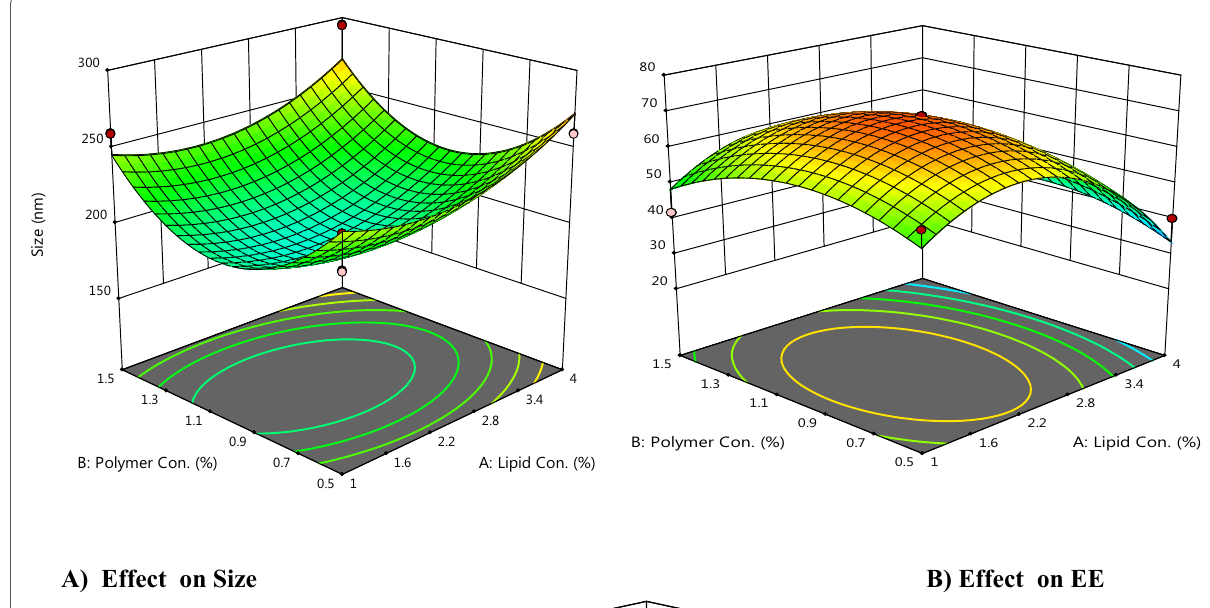
Fig. 1 Effect of responses by prepared